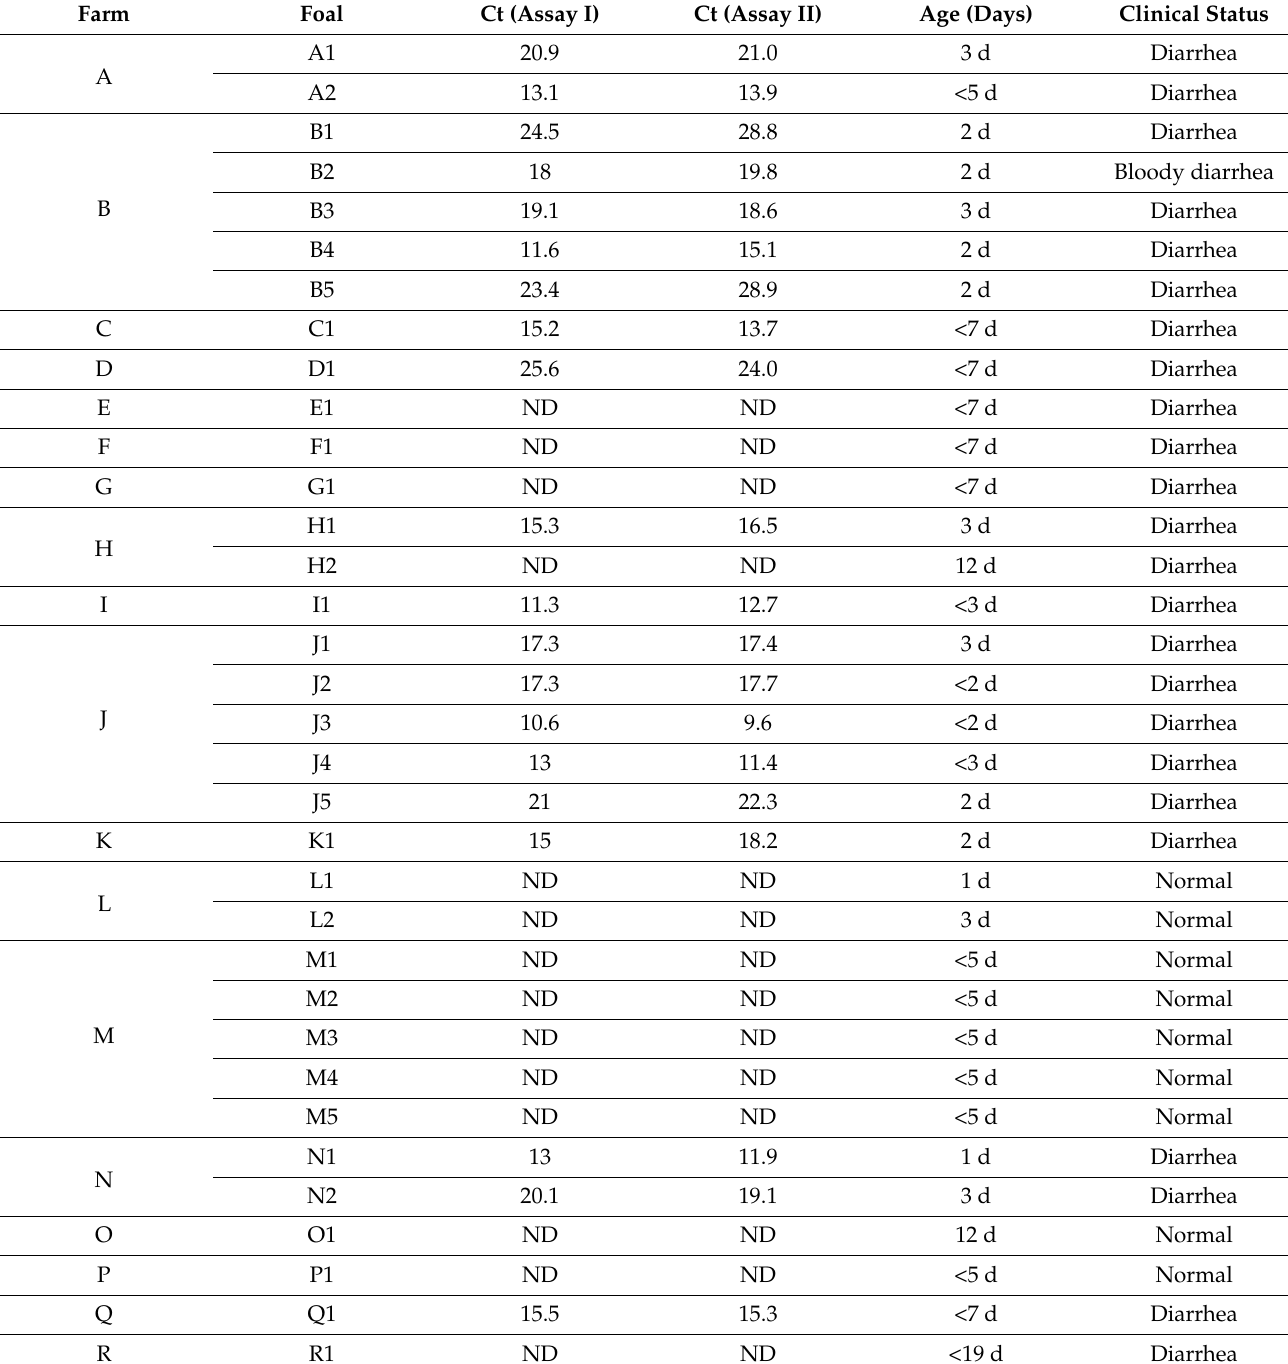
Table 3. Both assays were in complete agreement in the detection of the ERVB genome in these clinical samples qualitatively as well as quantitatively. Table 3. Detection of ERVB in clinical fecal samples of foals by